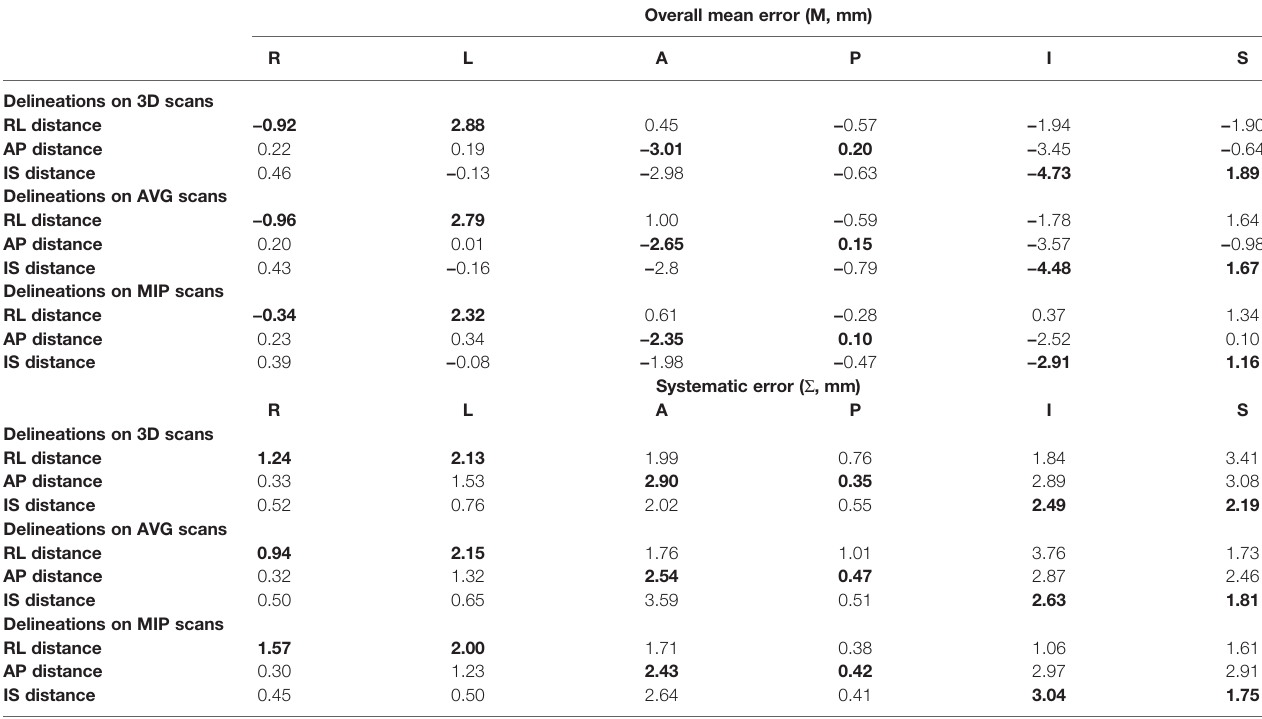
TABLE 3 | Overall mean errors and systematic errors for all extreme points and distance components for delineations on the 3D, AVG and MIP scans. Overall mean error (M, mm) R L A P S Delineations on 3D scans RL distance